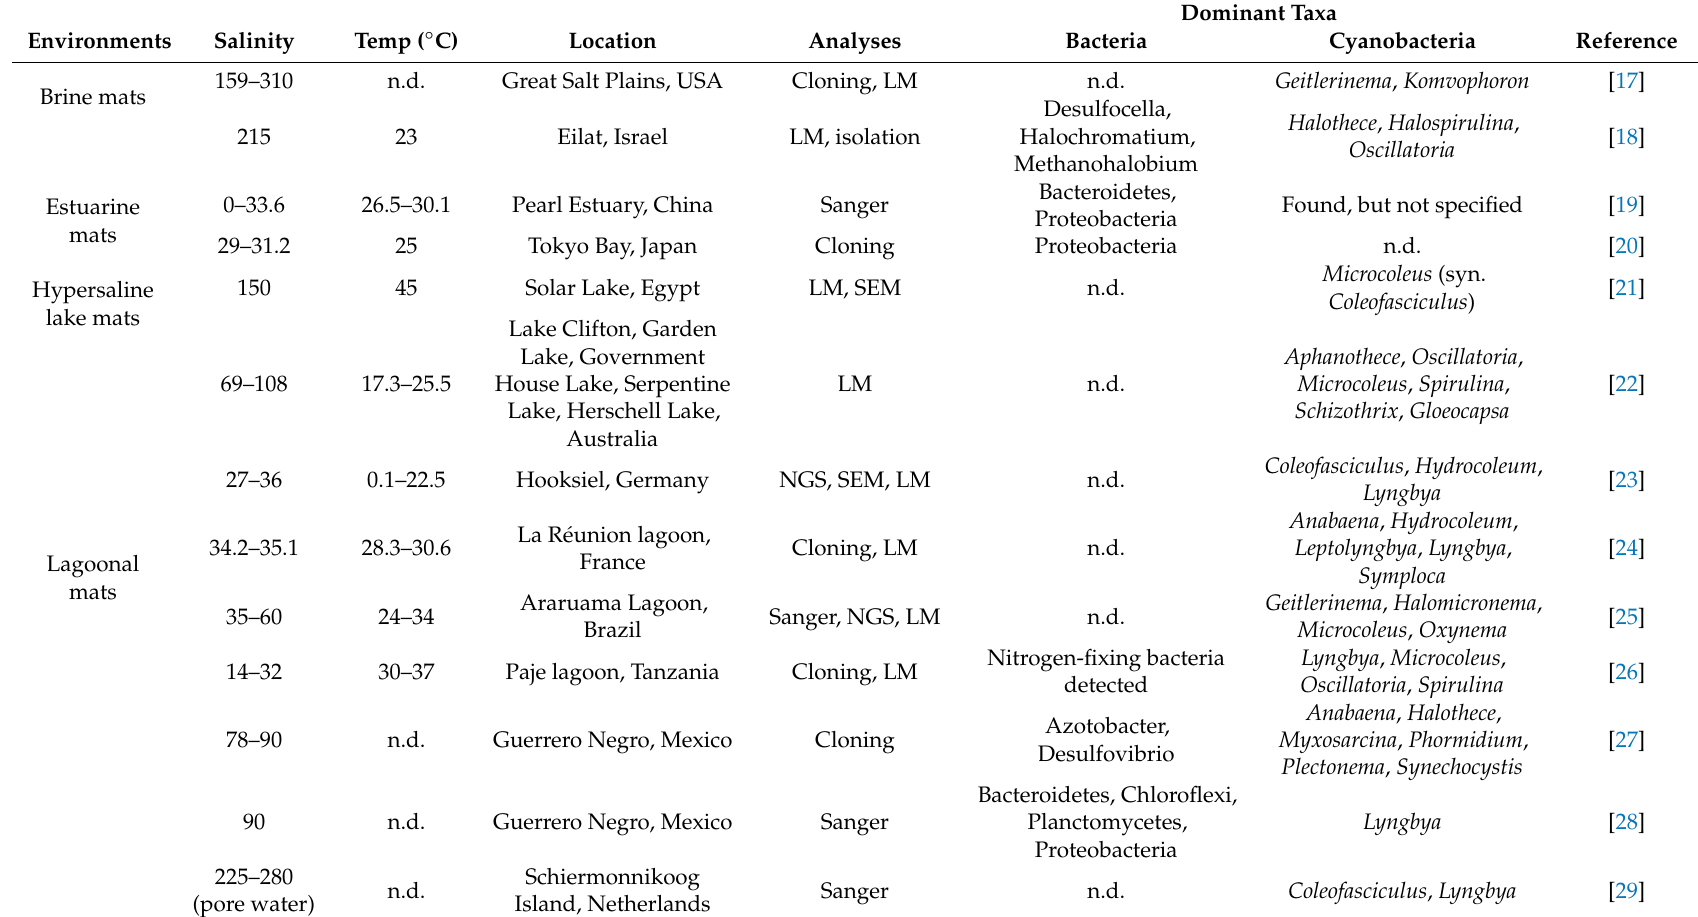
Table 1. Previous studies of microbial communities from hypersaline benthic